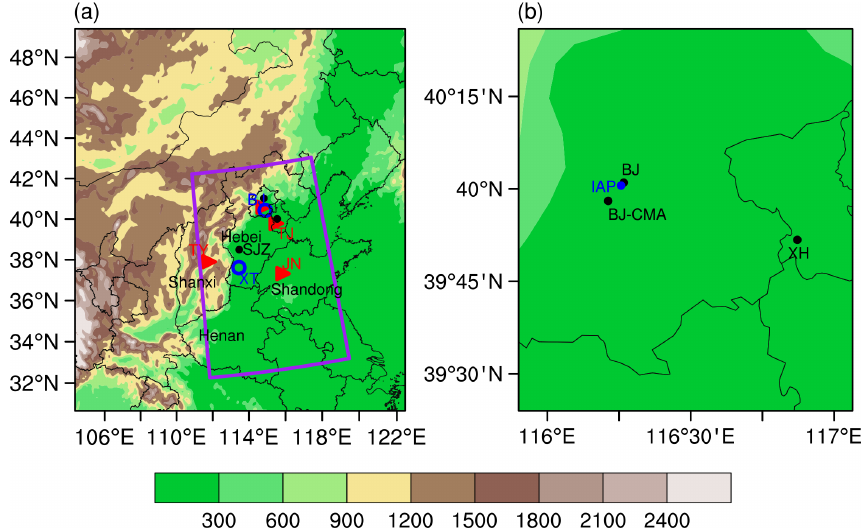
Figure 1. (a) The model domain and the terrain height (shadings, m). Purple box denotes the NCP, triangles are the observational sites of radiation (BJ: Beijing, TJ: Tianjin, TY: Taiyuan and JN: Jinan), circles are sites of sounding observation (BJ: Beijing and XT: Xingtai), dots denote the major cities for validation of PM 2 . 5 (BJ: Beijing, SJZ: Shijiazhuang and TJ: Tianjin). Names of provinces are also added (Hebei, Shanxi, Shandong and Henan). (b) The observational sites of AOD, including AERONET sites (black dots, BJ: Beijing, BJ-CMA: Beijing- CMA and XH: Xianghe) and the IAP in situ (blue dot)